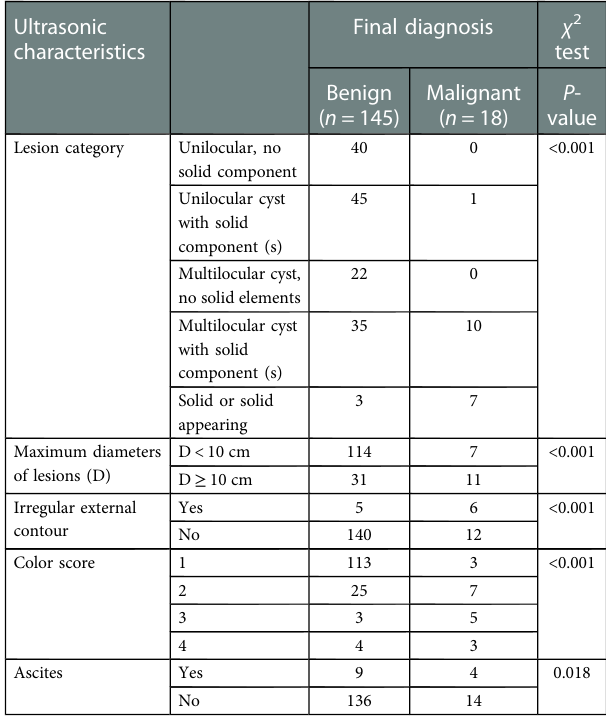
TABLE 2 Ultrasound characteristics of ovarian